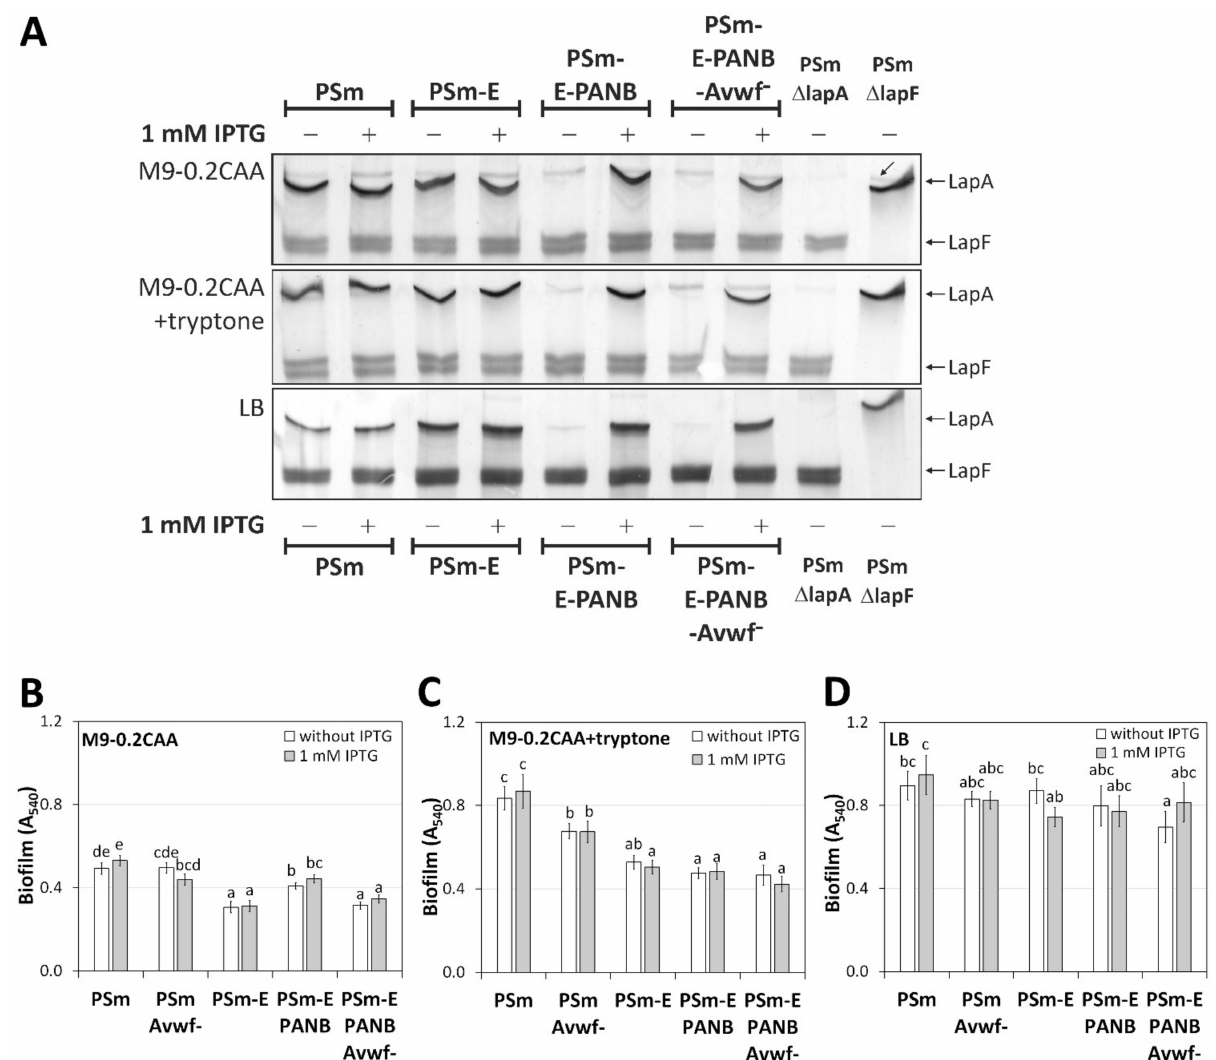
Figure 5. SDS-PAA gels and biofilm of P. putida PSm and PSm-E based strains and biofilm. ( A ) SDS-PAA gel electrophoresis of crude cell lysates, 40 µ g of total protein is loaded to each lane. The media in which cells were grown for preparing crude cell lysates are shown on the left of the gel image. Cells were grown with and without 1 mM IPTG. The strains used in the analysis are shown above and below the figure. PSm ∆ lapA and PSm ∆ lapF strains were used as negative con- trols for LapA and LapF. Arrows indicate LapA and LapF on the right side of the figure. Inclined arrows indicate an unknown protein complex. ( B ) Biofilm of PSm-based strains in M9-0.2CAA, ( C ) M9-0.2CAA+tryptone and ( D ) LB in the presence and absence of 1 mM IPTG. An arithmetical average of at least three biological parallels with 95% confidence intervals are given. Homogeneity groups are shown above the columns by lower-case letters. Identical letters denote nonsignificant differences ( p ≥ 0.05) between averages of biofilm. Multifactorial ANOVA was used for statistical analysis, analysed separately by